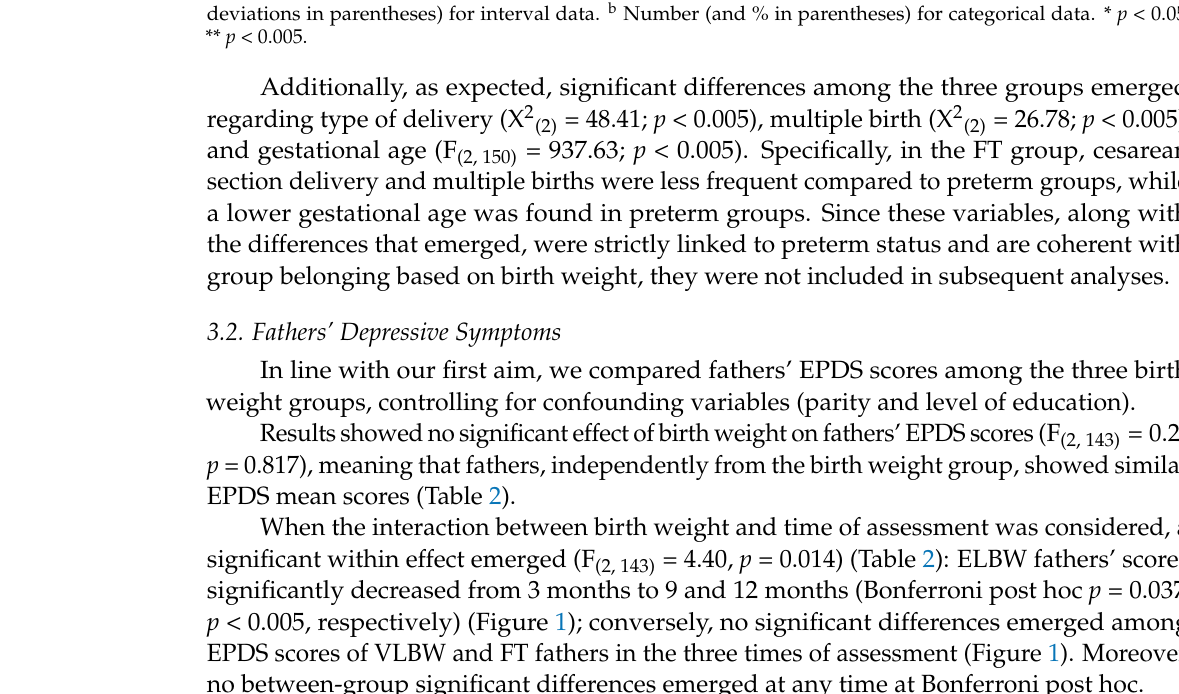
Figure 2. Fathers’ PSI total score related to birth weight and time of assessment. Note. ELBW = ex- tremely low birth weight; VLBW = very low birth weight; FT = full-term; T1 = 3 months; T2 = 9 months; T3 = 12 months. ** p < 0.005.